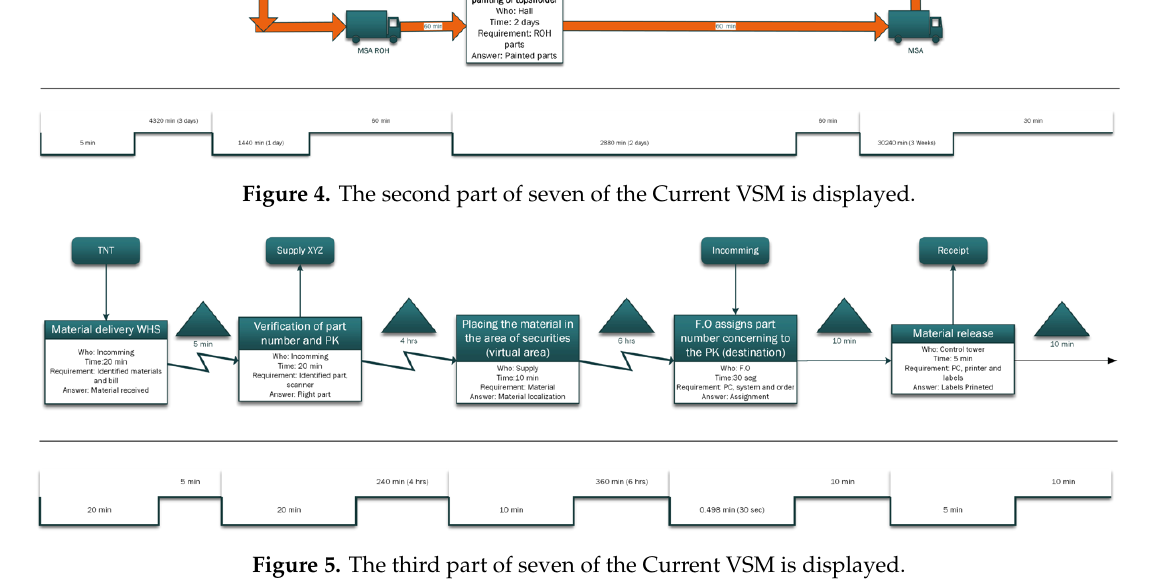
Figure 5. The third part of seven of the Current VSM is displayed.